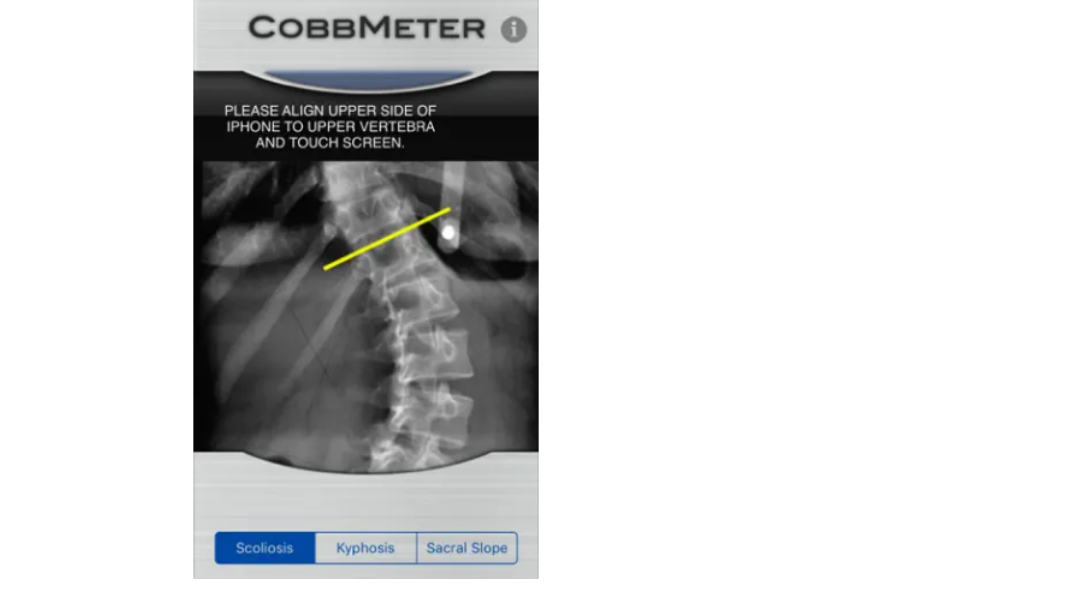
Figure 6. CobbMeter. (This figure is a snapshot taken by the screen of the app).